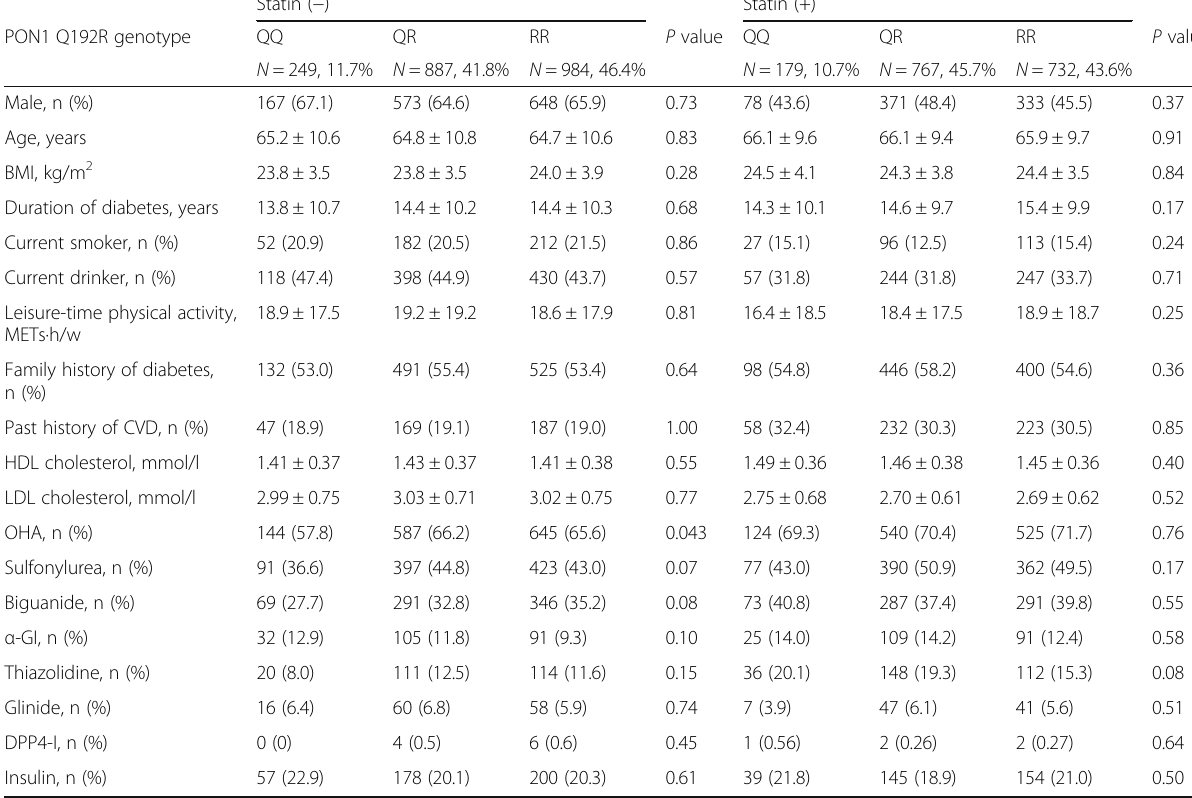
Table 1 Clinical characteristics in statin-treated or untreated patients with type 2 diabetes mellitus according to PON1 genotype Statin ( − ) Statin (+) PON1 Q192R